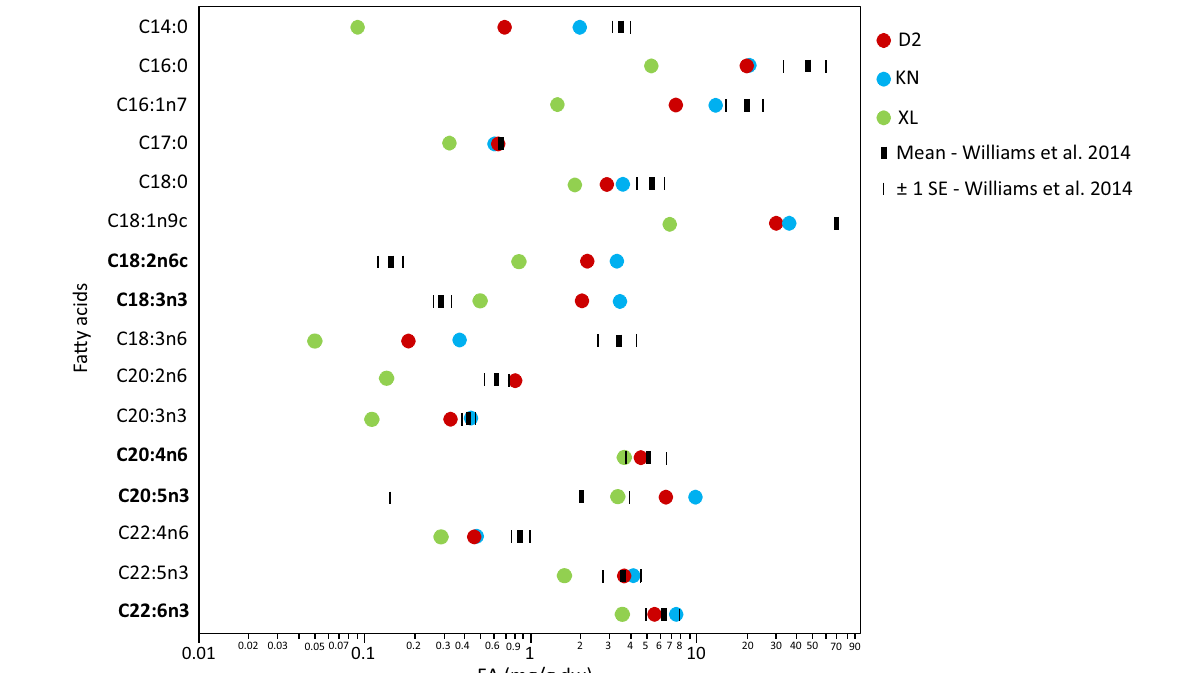
19) clustered into three primary groups: = 3) sampled from the = 1 SE, Williams et al. 2014). The essential fatty acids are indicated in bold text and ±